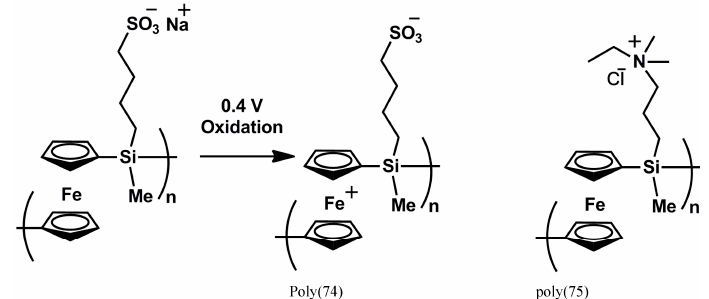
Figure 13. Switch from polyanionic ferrocene to polyzwitterionic ferrocenium state in poly(74) and chemical structure of positively charged polyferrocenylsilane poly(75).